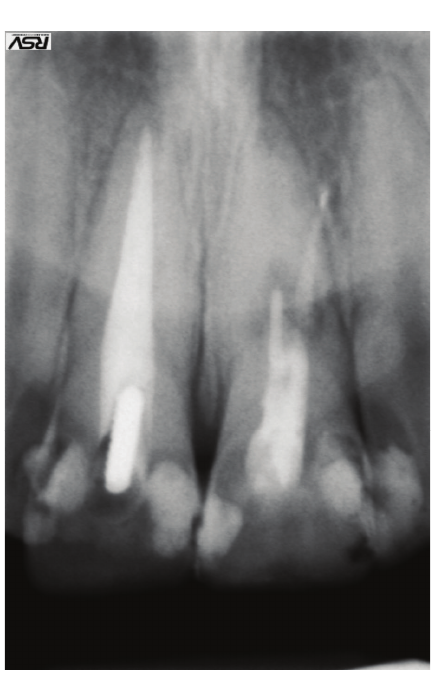
Figure 4: Initial